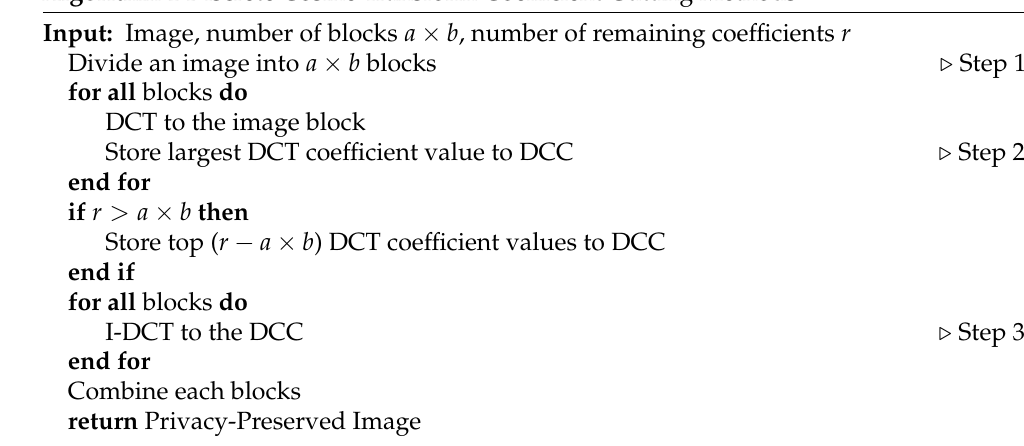
Algorithm 1 Discrete Cosine Transform Coefficient Cutting